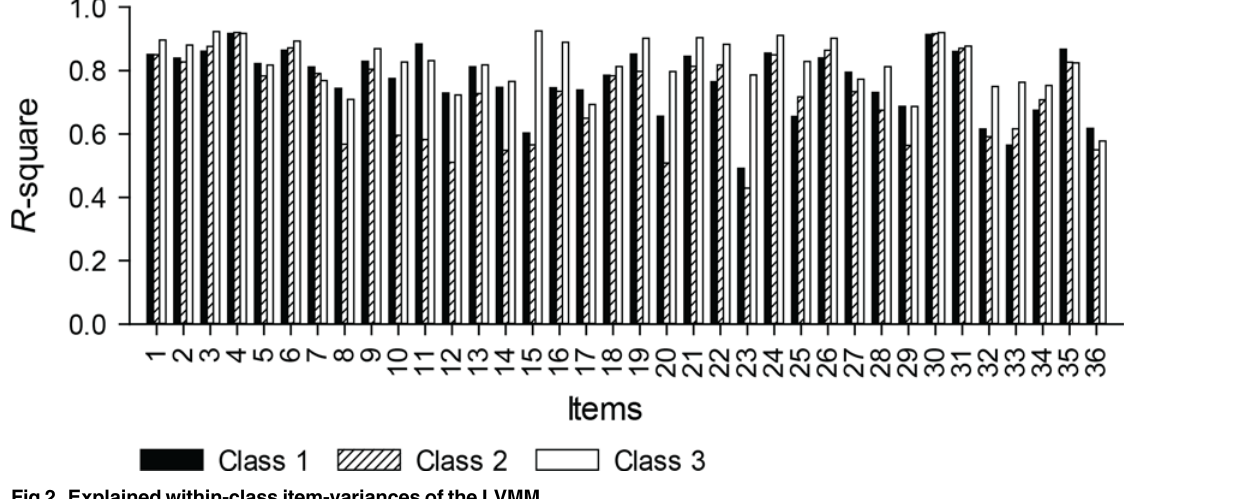
Fig 2. Explained within-class item-variances of the LVMM.